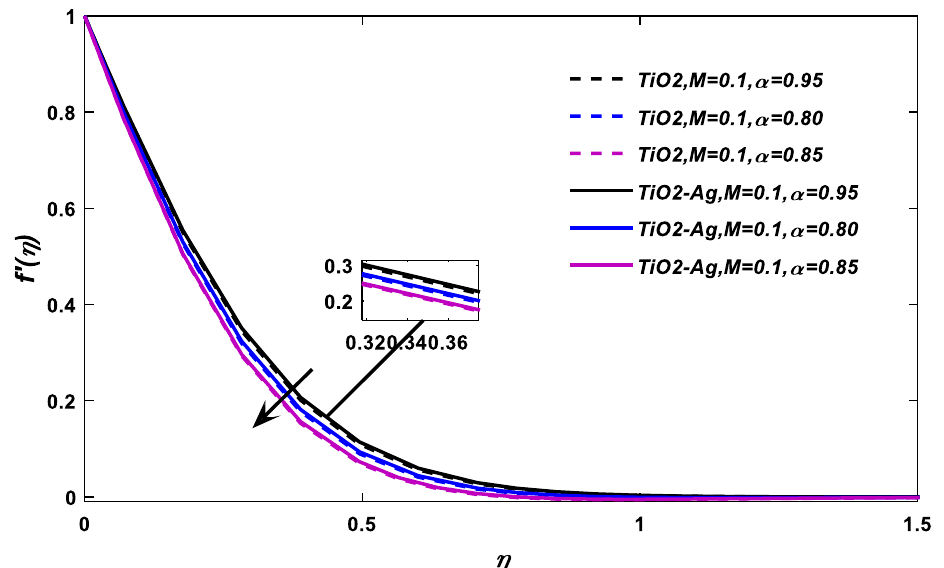
Figure 6. M versus velocity field when E = 0.1, (cid:31) = 0.01, φ 1 , φ 2 = 0.02, Pr = 21.